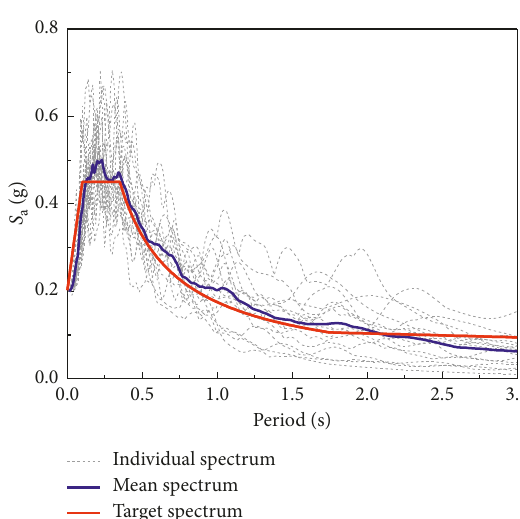
Figure 34: Response spectrum of earthquake records scaled to DBE.